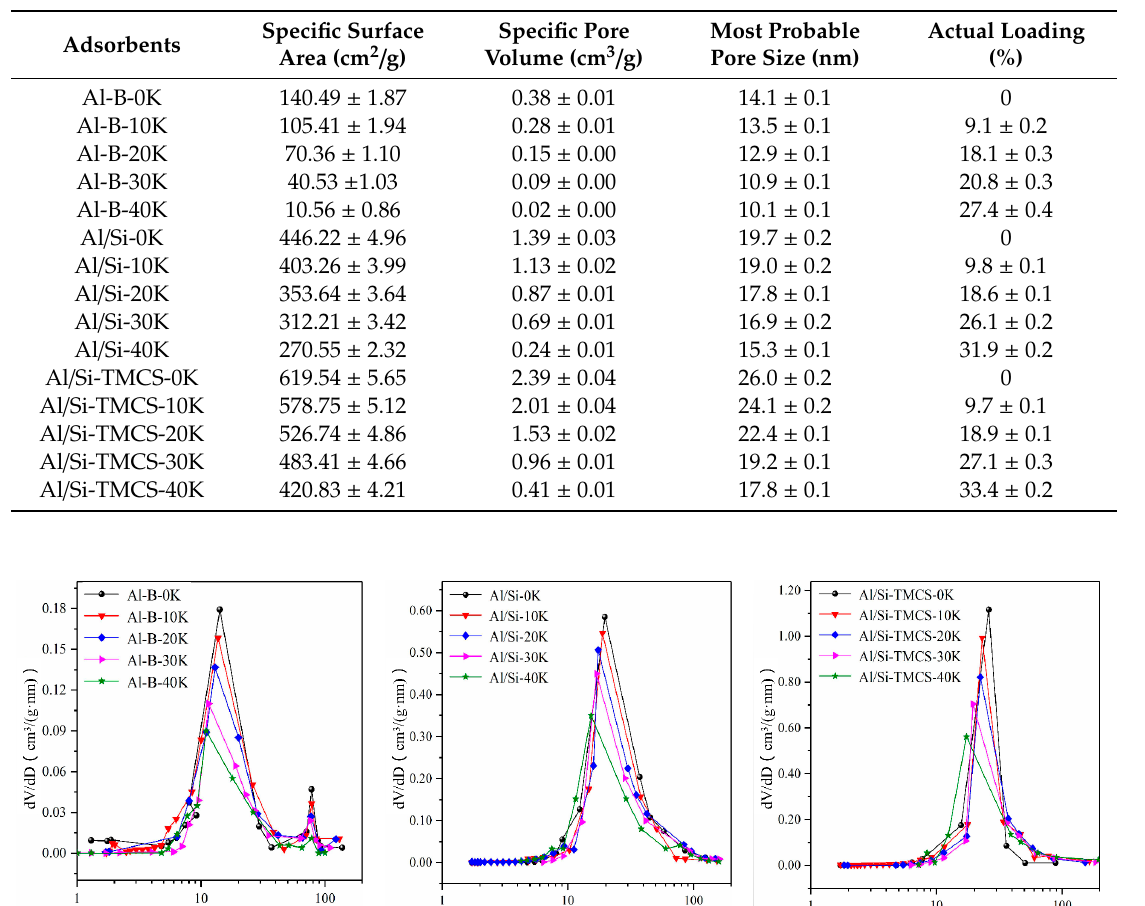
Table 3. Microstructure parameters of the adsorbents.